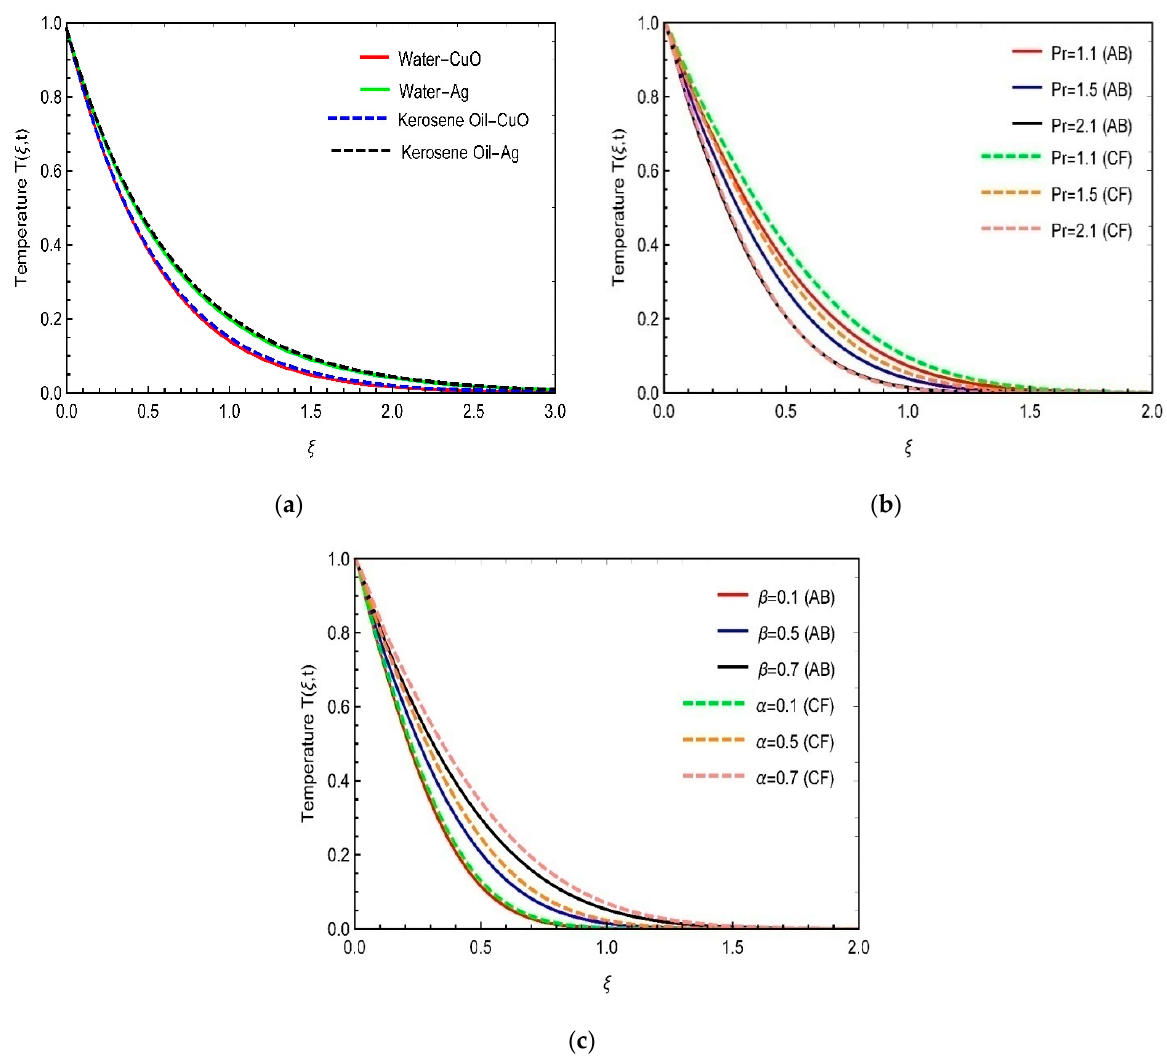
Figure 7. ( a – c ): ( a ) Comparative temperature profile for water- and kerosene-based nanofluids, ( b ) change in temperature for Pr , and ( c ) change in temperature for β . Table 2. The numerical outcomes for temperature and velocity profiles via Stehfest [31] and Tzou’s [32] integration tools.